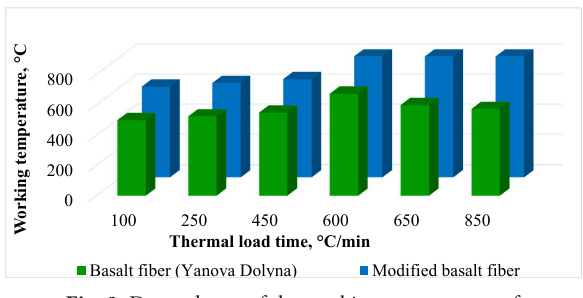
Fig. 9. Dependence of the working temperature of basalt fiber on the time of thermal load ( T t.l. – 1060 °C, Ø 180–250 microns)